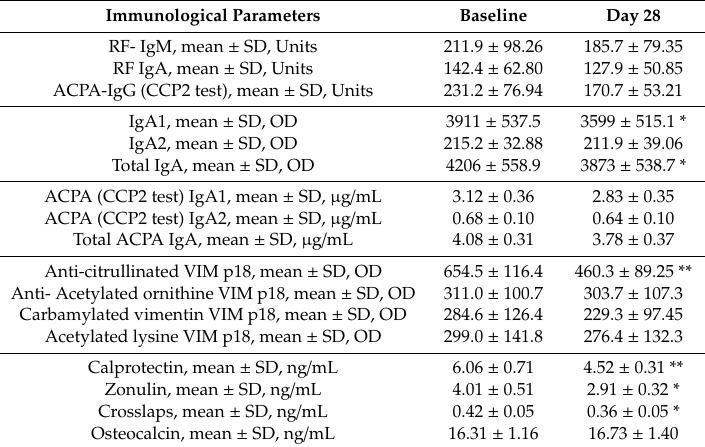
Table 4. Serum parameters of participating